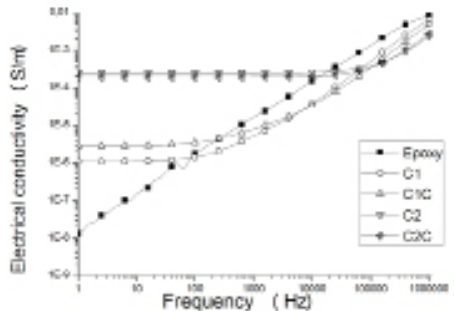
Figure 4. Electrical conductivity as function of frequency for neat epoxy, epoxy/CNT nanocomposites with 0.05 and 0.1 wt % of CNT and epoxy/CNT/calcium carbonate with 0.05 and 0.1 wt % of CNT.